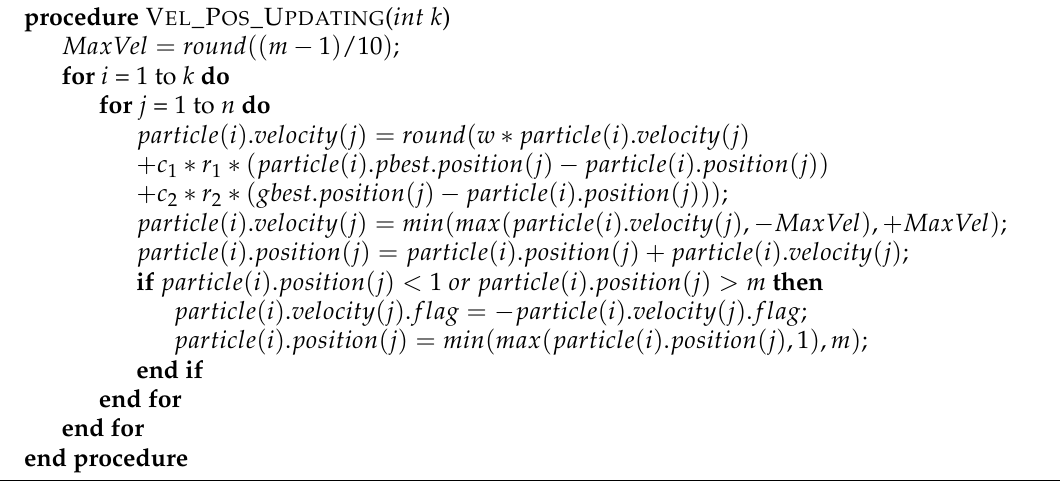
Algorithm A3 Pseudocode of velocity and position